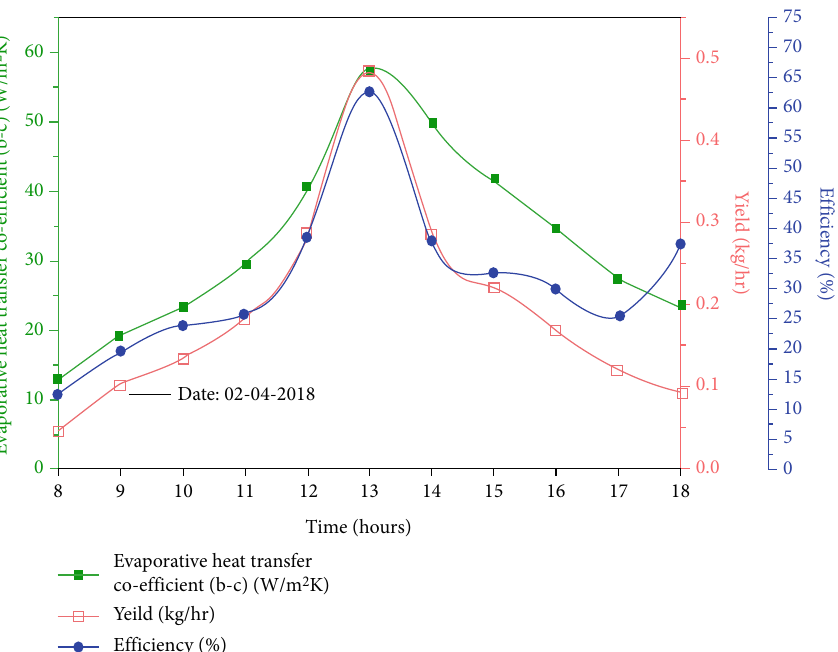
Figure 28: E ffi ciency, productivity, and evaporative heat transfer coe ffi cient of the conventional pyramid shape solar still [63].